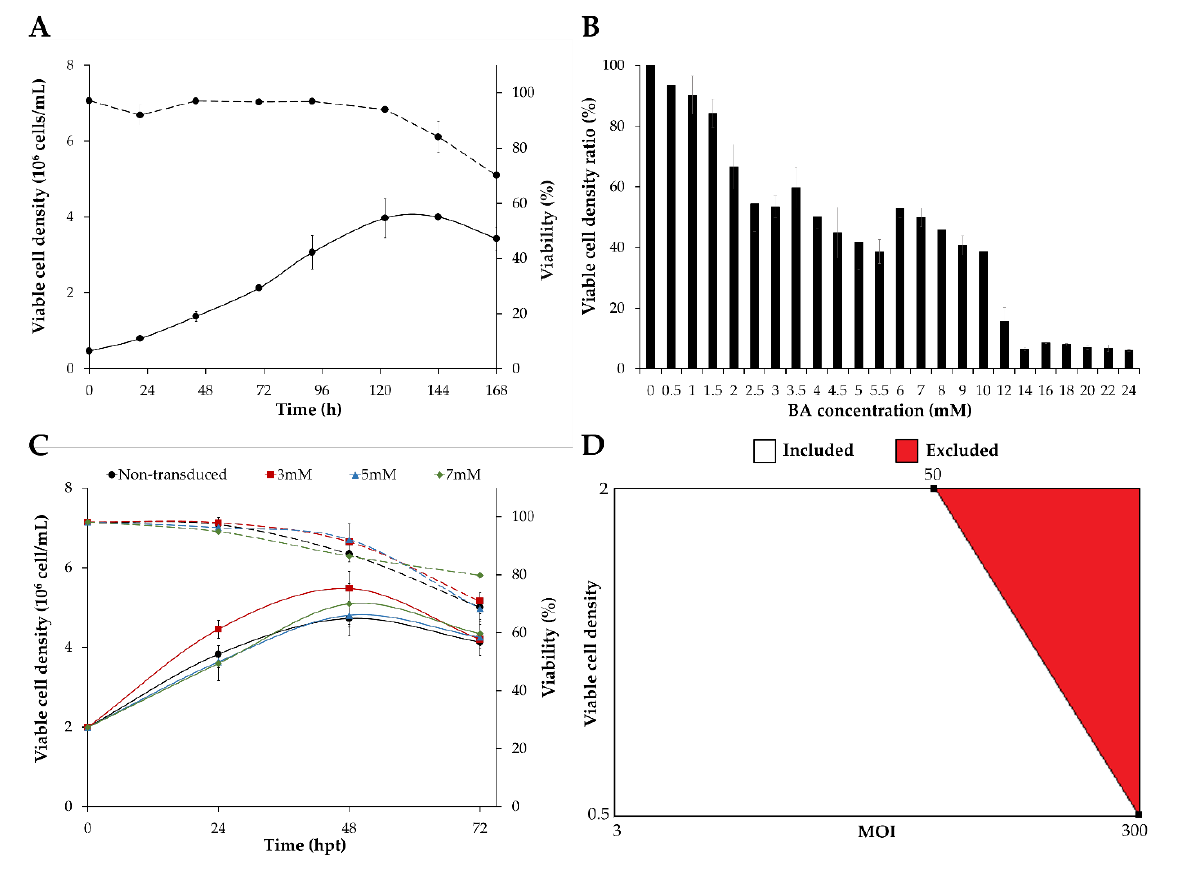
Figure 1. Definition of critical parameters for HEK293 cell transduction and D-optimal design. ( A ) Cell growth and viability profiles of HEK293 cells cultured in 20 mL of supplemented FreeStyle 293 medium. Cells were seeded at 0.5 × 10 6 cell/mL in 125 mL shake flasks. ( B ) Cytotoxicity analysis of different butyric acid concentrations (0–24 mM) on HEK293 cells seeded at 5 × 10 4 cell/well in 96-well plates. Data is expressed as the ratio of viable cell density at different BA concentrations compared with the no BA (0 mM) condition. ( C ) Addition of 3, 5 and 7 mM of butyric acid to HEK293 cells cultured in shake flasks with 20 mL of supplemented FreeStyle 293 medium and seeded at 2 × 10 6 cell/mL. ( D ) Computer-generated D-optimal design. BA: butyric acid, hpt: hours post transduction, MOI: multiplicity of infection.